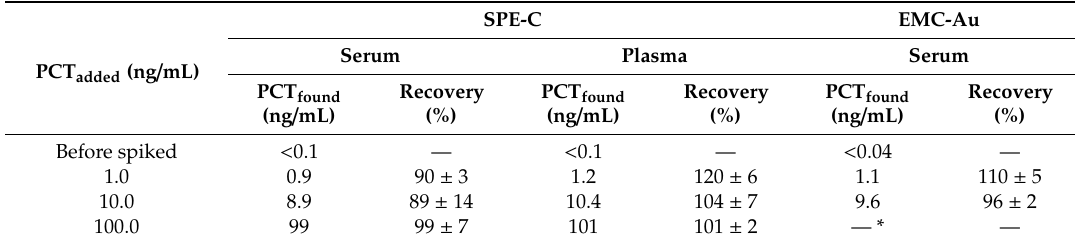
Table 3. PCT determination in human plasma and serum samples.